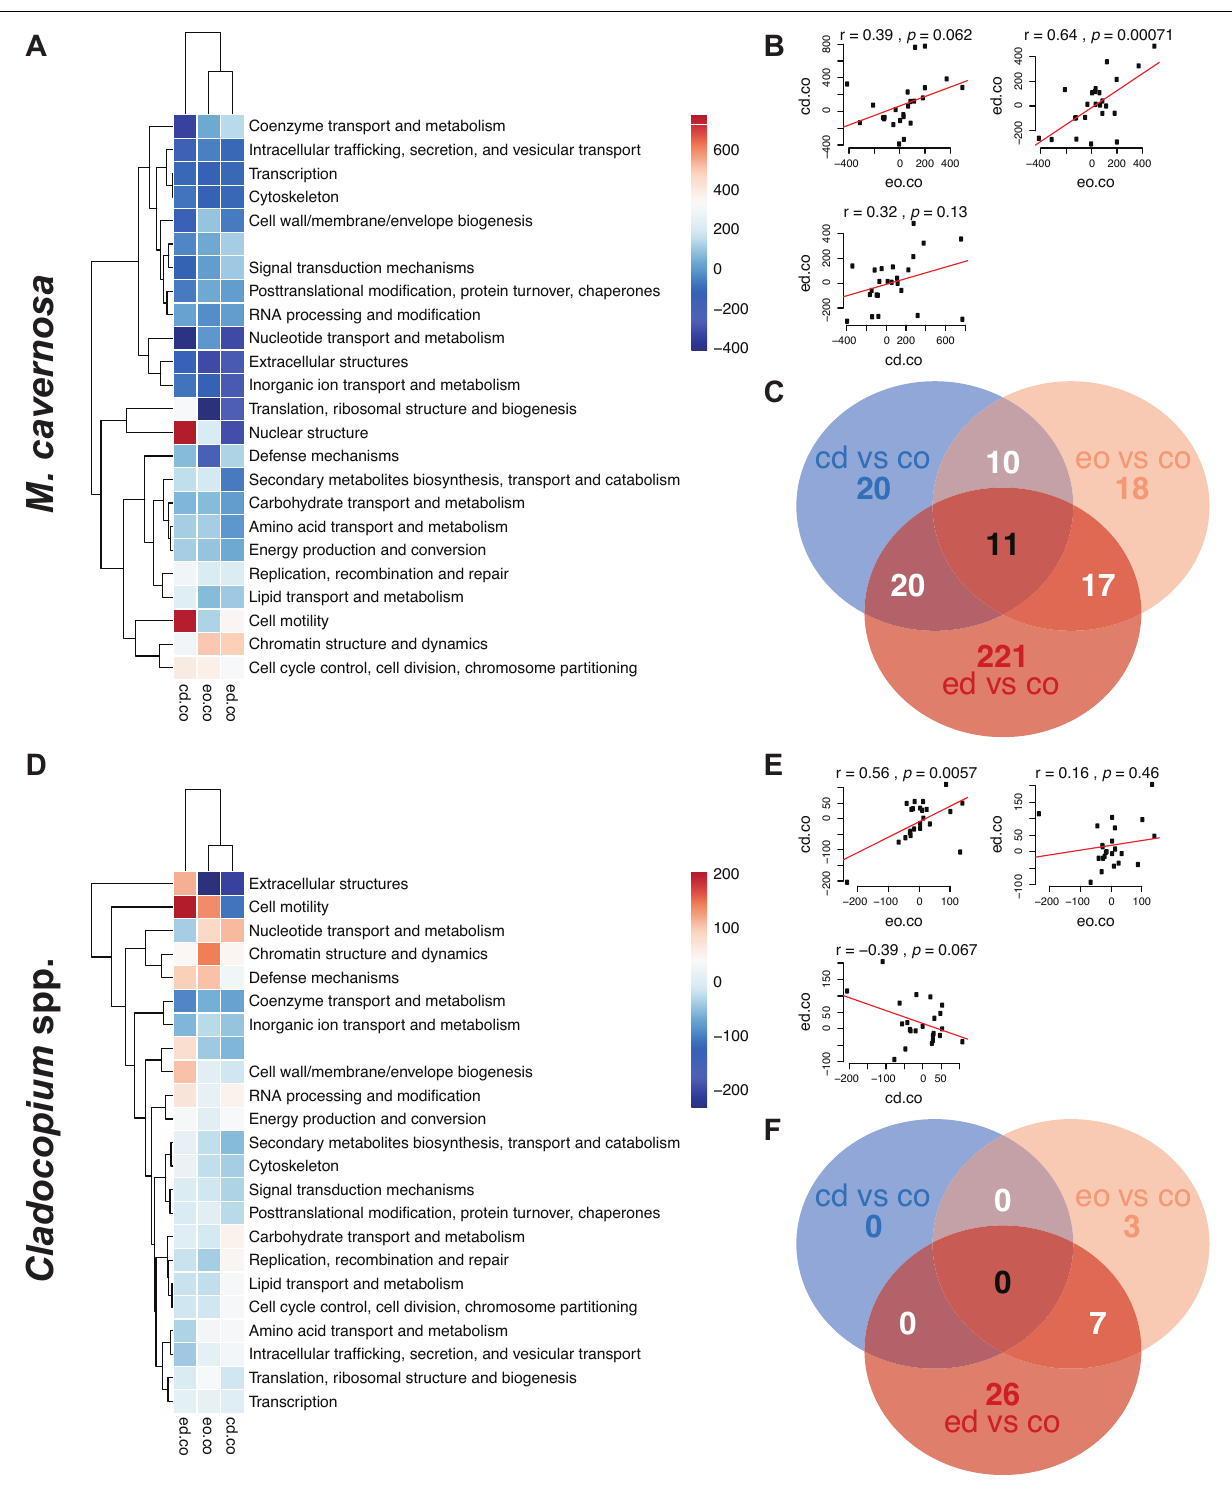
Frontiers in Marine Science |